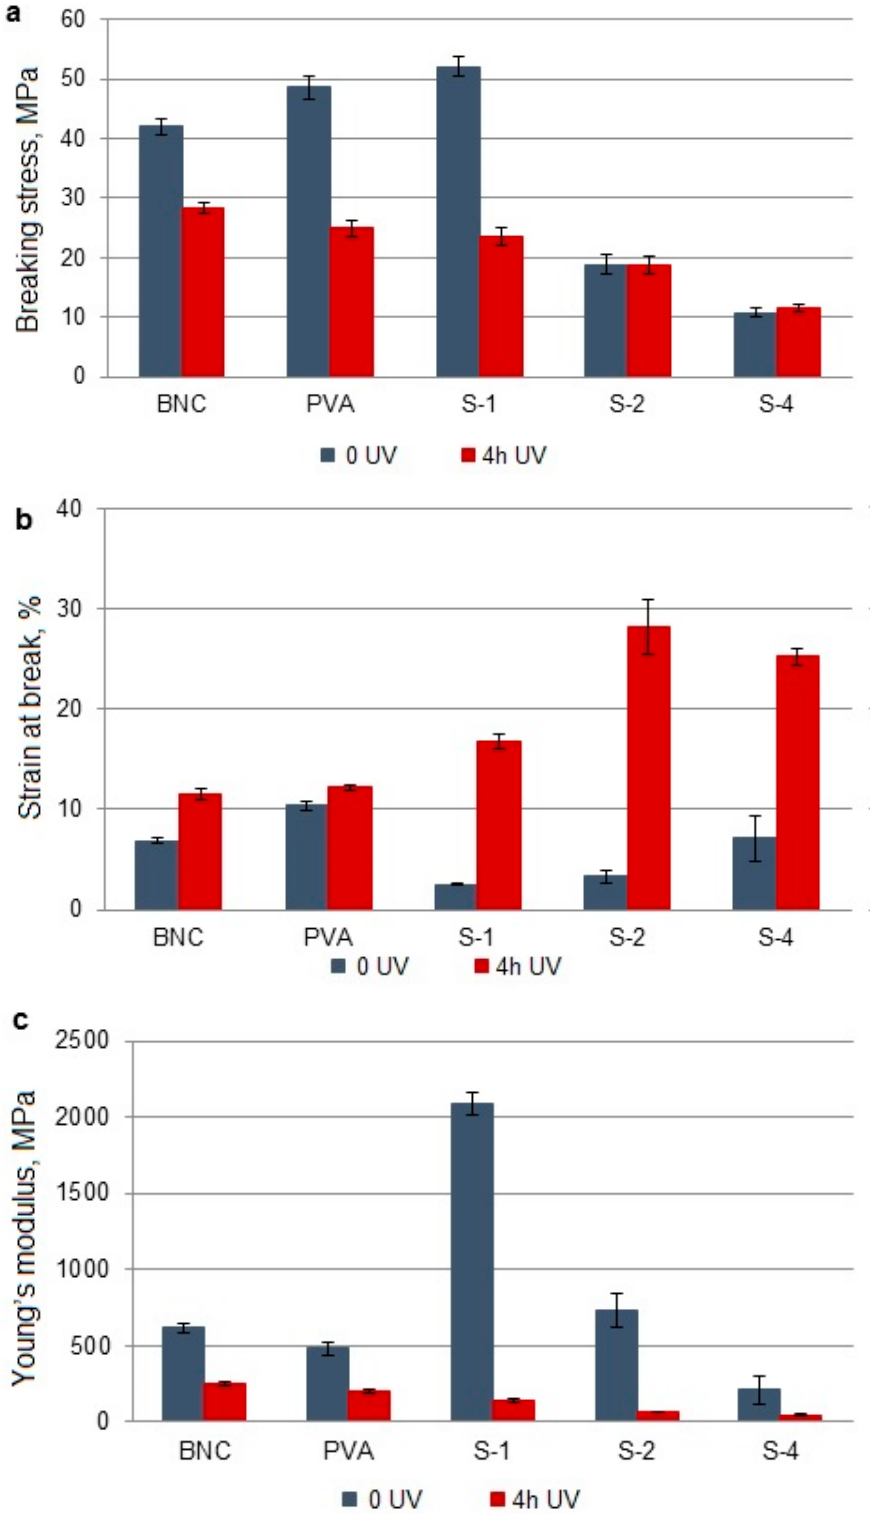
Figure 5. Mechanical properties of BNC, PVA, and their blends obtained by ex situ/sterilization before and after UV irradiation: breaking stress ( a ), strain at break ( b ), and Young’s modulus ( c ).